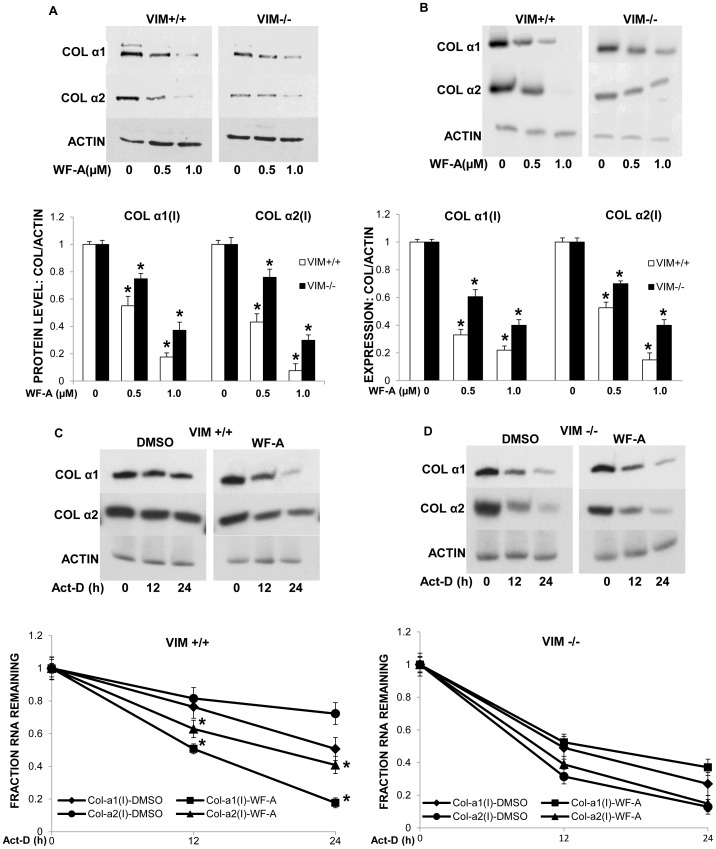
Effects of WF-A on collagen expression in vimentin knock-out fibroblasts.A. Expression of collagen polypeptides in vimentin knock-out fibroblasts treated with WF-A. Wild type mouse embryonic fibroblasts (VIM+/+ MEFs, upper right panel) and vimentin knock-out (VIM−/− MEFs, upper left panel) were treated with WF-A and collagen α1(I) and α2(I) polypeptides analyzed by Western blotting. Loading control: actin. Bottom panel: the expression of collagen α1(I) and α2(I) polypeptides from VIM+/+ MEFs (open bars) and VIM−/− MEFs (black bars) was normalized to actin expression andresults from three independent experiments were plotted. The error bars represent ±1SEM. B. Effect of WF-A on expression of collagen mRNAs in VIM+/+ and VIM−/− MEFs. Experiment as in A, except mRNAs were analyzed by RT-PCR. C. WF-A destabilizes collagen mRNAs in VIM+/+ MEFs. VIM+/+ MEFs were treated with DMSO (left panel) or 1.0 µM WF-A (right panel) for 24 h. Transcription was then blocked by Act-D and collagen α1(I) and α2(I) mRNAs were measured at the indicated times after the block by RT-PCR. Actin mRNA was measured as a loading control. Bottom panel: VIM+/+ MEFs treated with WF-A (full lines) or DMSO (broken lines) and the levels of collagen α1(I) mRNA (circles) and α2(I) mRNA (squares) were normalized to actin mRNA and plotted for the indicated time points after the transcription block. The level at time point 0 was arbitrarily set as 1. The error bars represent ±1 SEM, estimated from three independent experiments. D. WF-A has no effect on stability of collagen mRNAs in VIM−/− MEFs. Experiment as in C, except in VIM−/− MEFs were used. * represents p<0.05.